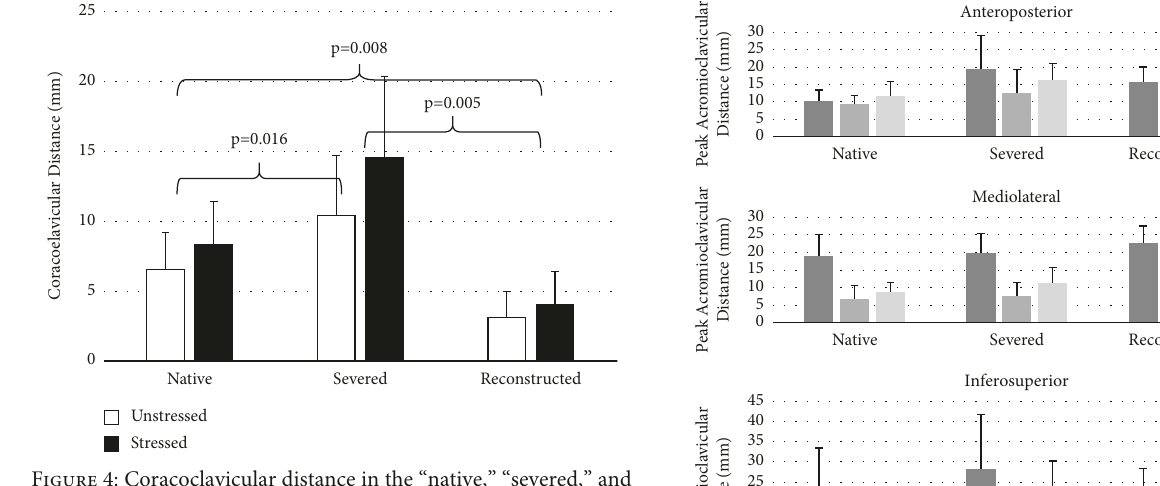
Figure 4: Coracoclavicular distance in the “native,” “severed,” and “reconstructed” states measured using unstressed and stressed zanca views. Brackets and p -values indicate statistical